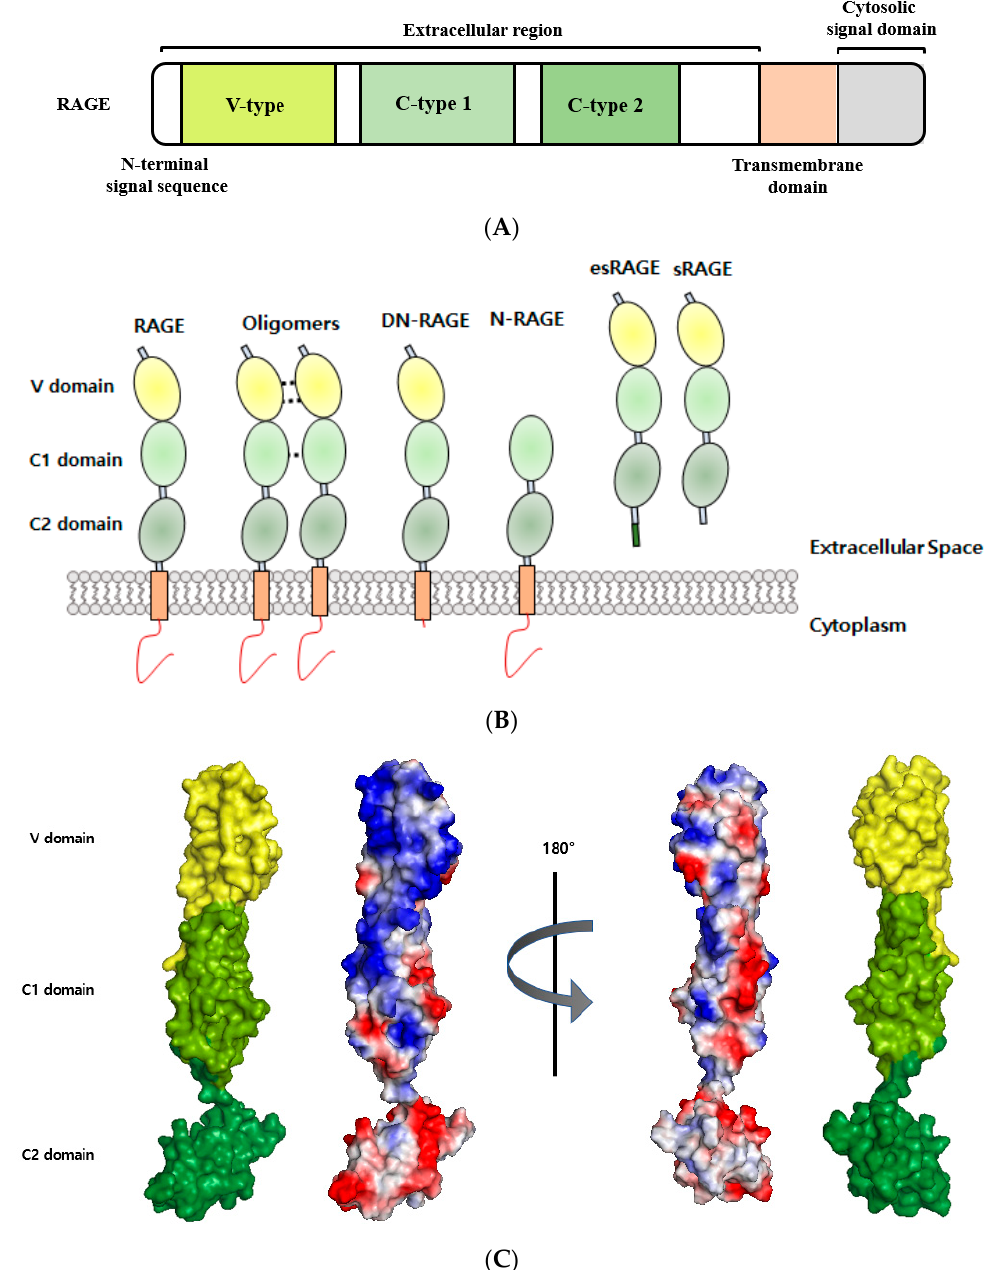
Figure 1. Structural analyses of RAGE. ( A ) Schematic representation of full-length RAGE domain. RAGE consists of a variable (V) domain, two constant (C1 and C2) domains, a transmembrane region, and a cytoplasmic tail. ( B ) RAGE isoforms. RAGE isoforms in the illustration include (from left to right) full-length RAGE, oligomers, dominant-negative RAGE (DN-RAGE), N-truncated RAGE (N-RAGE), endogenous secretory (esRAGE), and soluble form RAGE (sRAGE). ( C ) The surface of RAGE colored according to electrostatic charges (PDB ID: 4YBH). Positively charged areas are shown in blue, and negative charged areas in red. The figure was prepared using PyMOL.